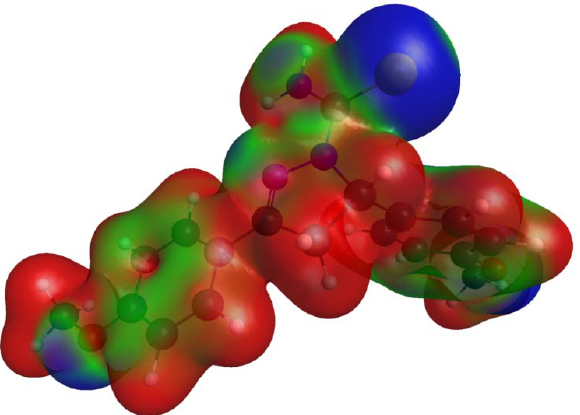
Figure 4. Electron density map for 1 with negative and positive regions represented in blue and red colors, respectively.